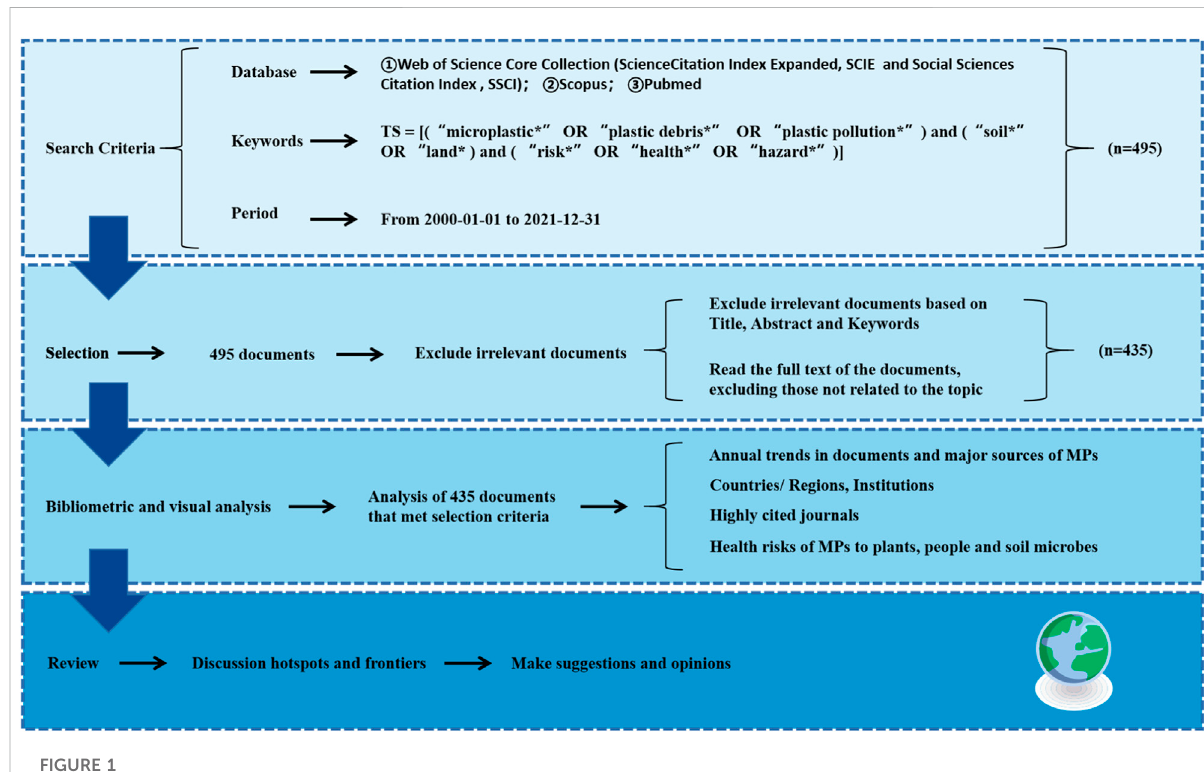
FIGURE 1 Document selection and fl owchart for the health risks of soil microplastics.